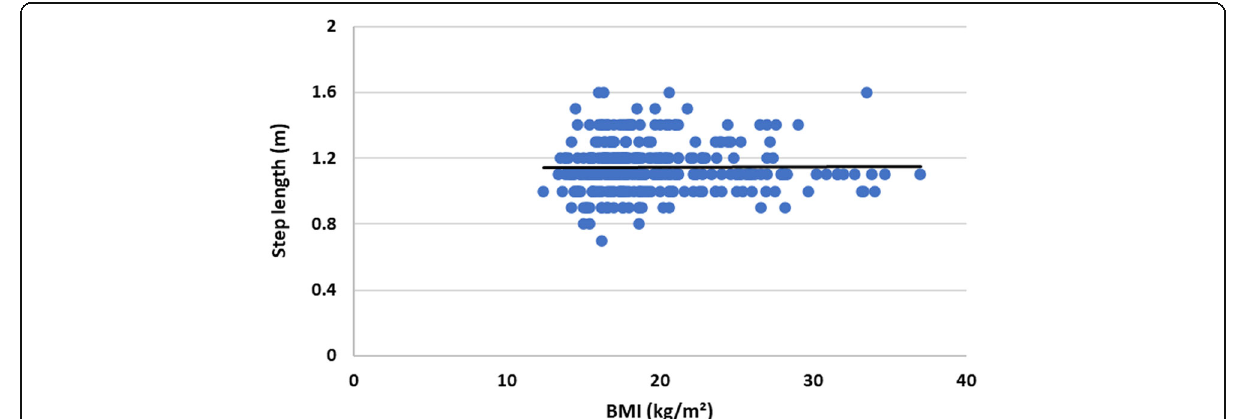
Fig. 1 Correlation between BMI and step length of the